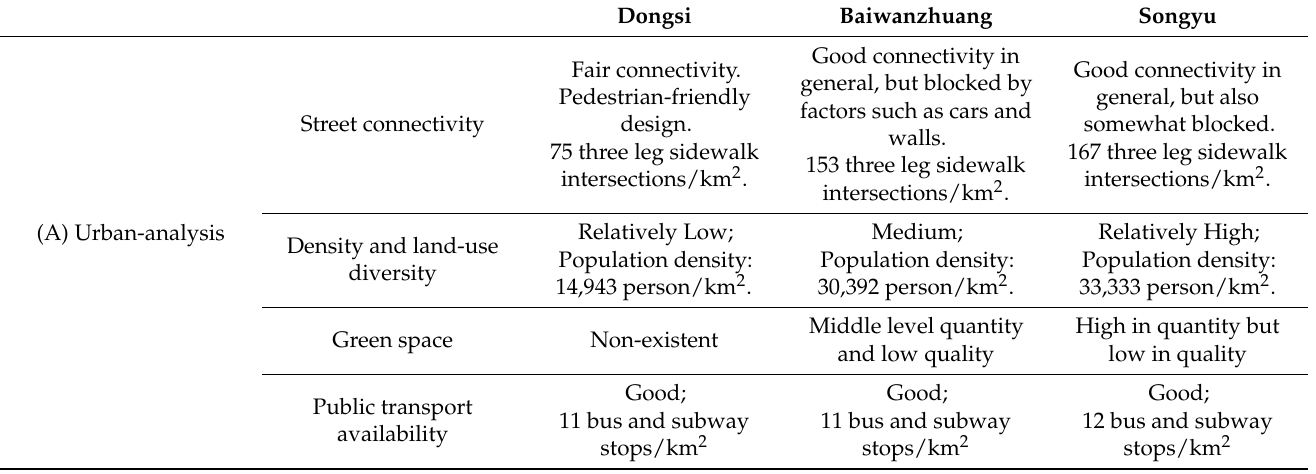
Table 6. Comparison of main built environment dimensions and PA levels in three